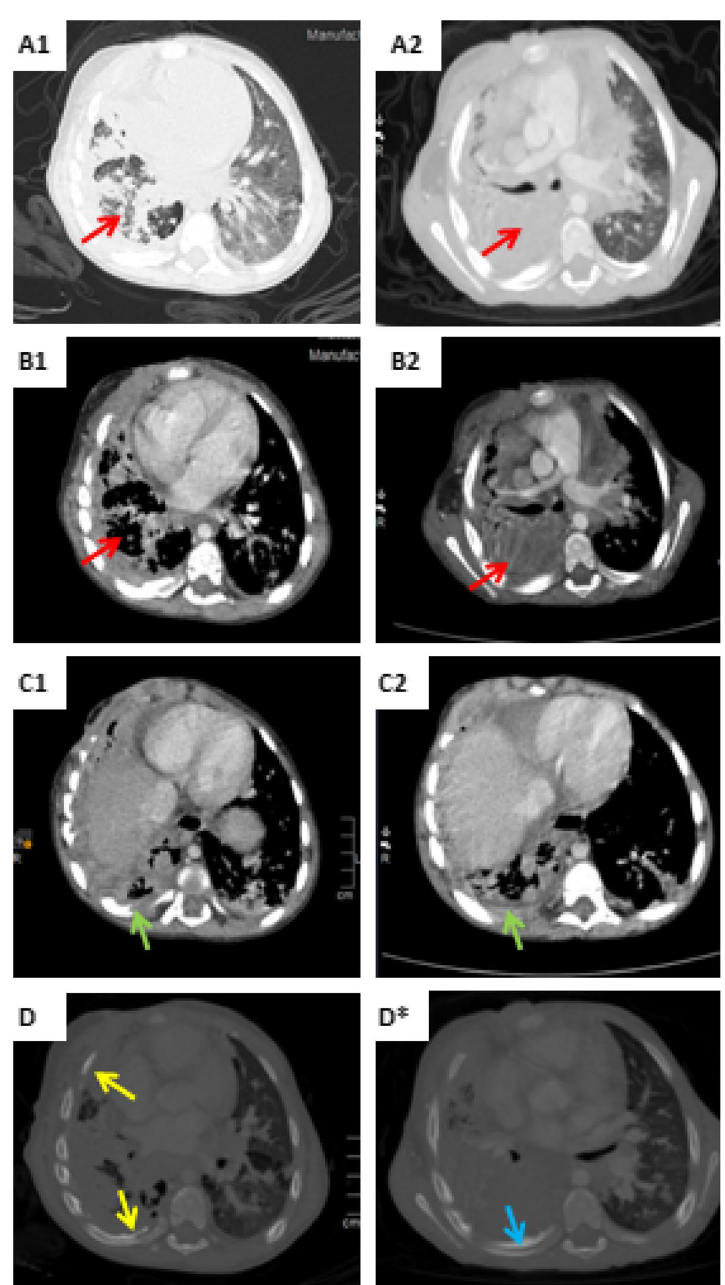
Fig. 5 Chest CT scans three months apart. (A1, A2), (B1, B2), and (C1, C2): enhanced chest CT scans at a 3-month interval in the parenchymal ( A ) and mediastinal ( B , C ) windows, showing a reduction in parenchymal consolidation (red arrows) with a decrease in the right lung volume. The disappearance of the small right pleural effusion was also noticed (green arrow). D , D * Chest CT scan in bone reconstruction showing bone lesions of the anterior and posterior costal arches: lytic bone lesions with cortical thickening ( D , yellow arrow), periosteal reaction ( D *, blue